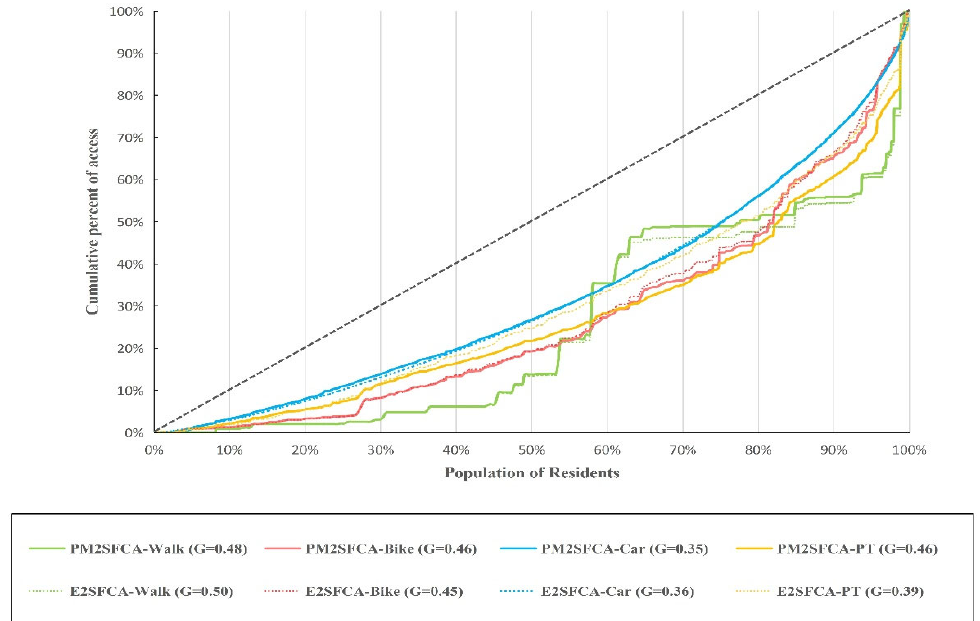
Figure 14. The Gini index and Lorenz curve of park accessibility.